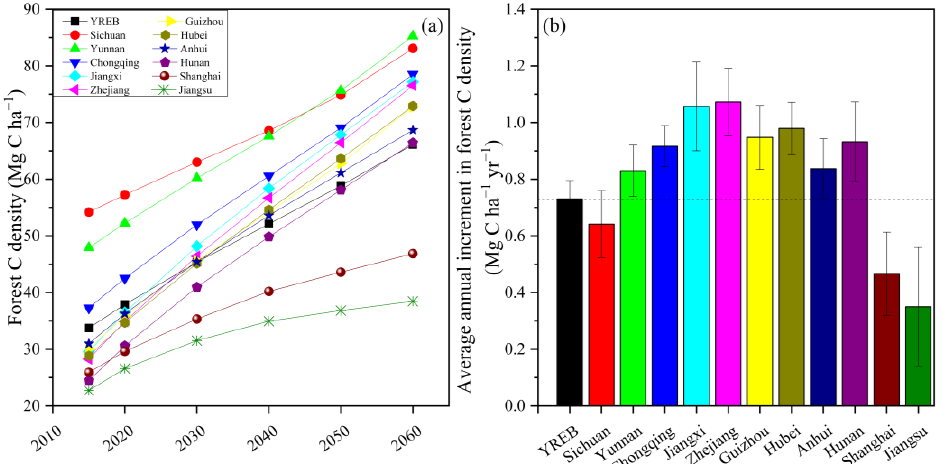
Figure 5. Predicted variations in forest biomass C density from 2015 to 2060 in the YREB. ( a ) shows the forest biomass C density of the YREB and various provinces and municipalities from 2015 to 2060; ( b ) represents the average biomass C density of forests in the YREB and various provinces and municipalities from 2015 to 2060. The dotted line refers to the average annual increment C density of forest biomass in the YREB.